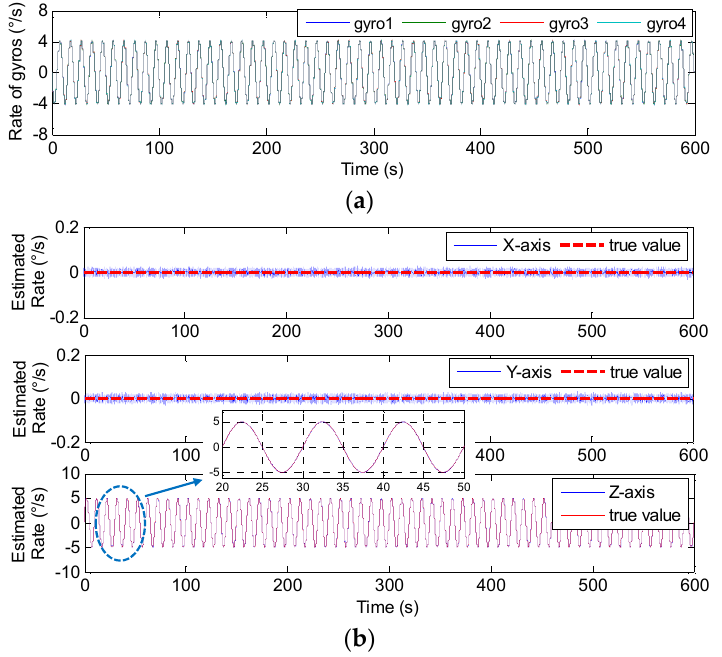
Figure 24. The swing test results of 4-MIMU with ω z = 5 × sin(2 π ft )° /s ( f = 0.1 Hz). ( a ) The outputs of gyros. ( b ) The estimated rate of the MIMU on the X b , Y b and Z b axes. Table 9. The estimated errors (1 σ ) of 4-MIMU for the swing test ( ω z = 5 × sin(2 π ft )).